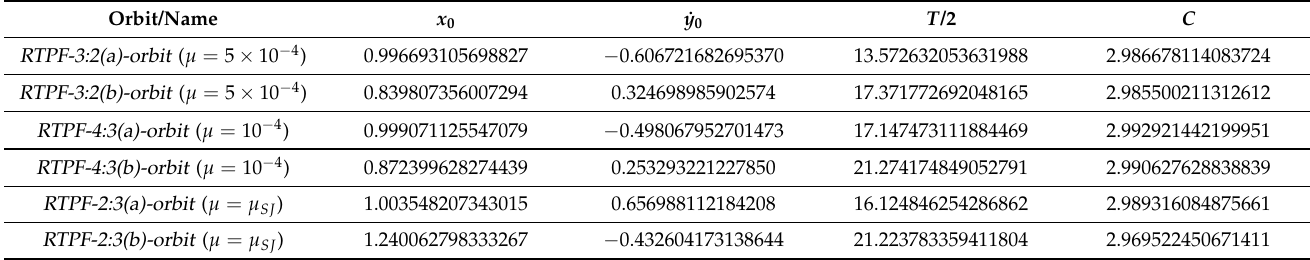
Table 2. Initial states of the example RTPOs shown in Figure